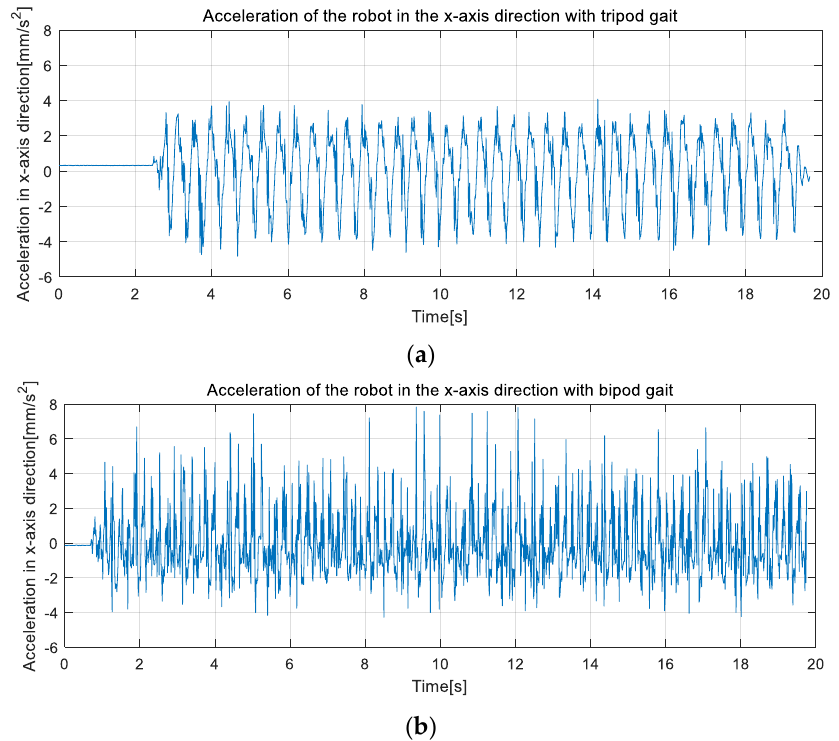
Figure 17. The experimental result of the physical prototype. ( a ) The acceleration variation on the X − axis as the robot advanced with a tripod gait, ( b ) The acceleration variation on the X − axis as the robot advanced with a bipod gait.